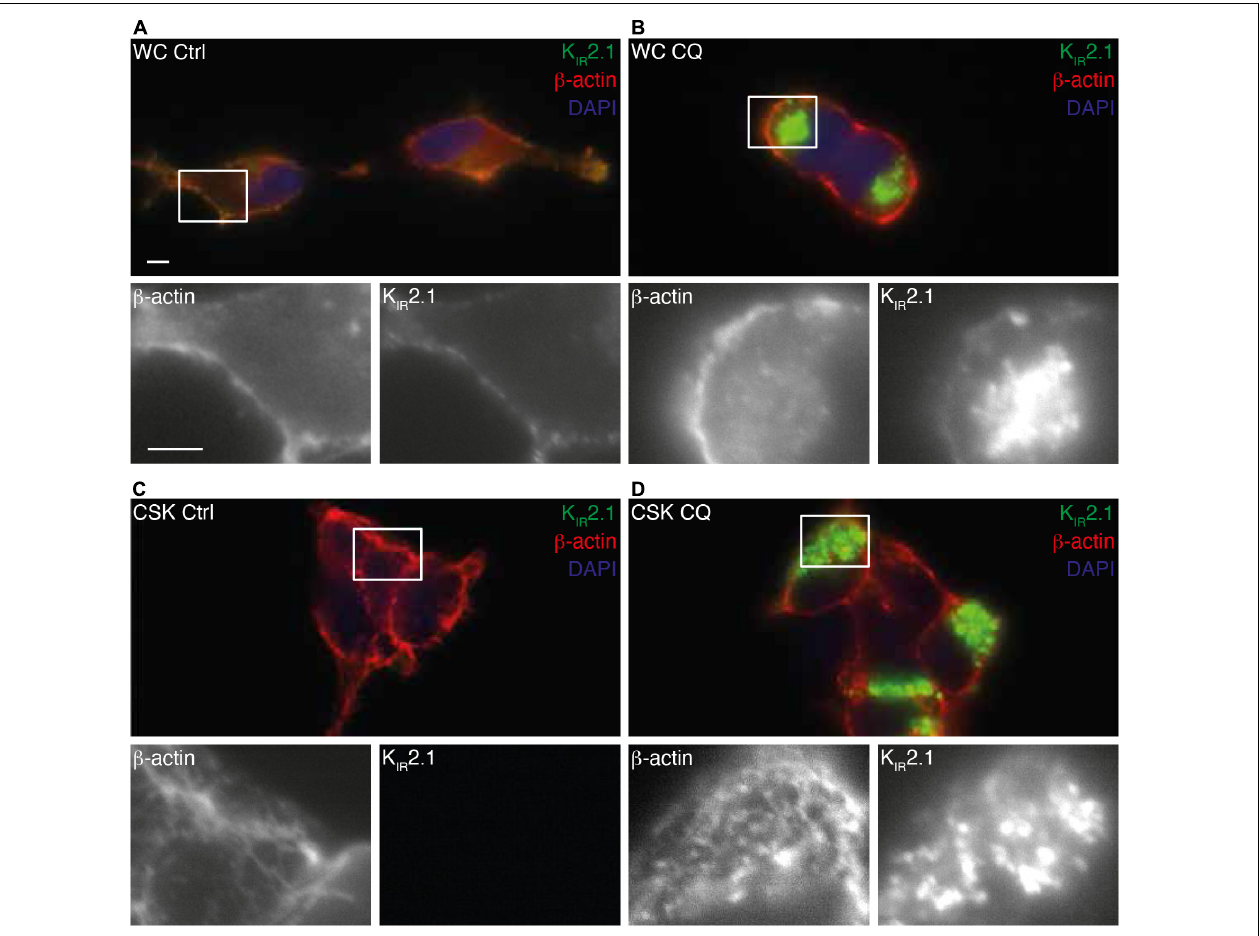
FIGURE 6 | Interaction of K IR 2.1-GFP with the cell cytoskeleton following Chloroquine treatment. Co-staining of K IR 2.1-GFP (green) and β -actin in non-treated whole cell (WC) (A,B) or cytoskeleton isolated (CSK) (C,D) HEK-KWGF cells. Cells were either non-treated (Ctrl) (A,C) or treated with 10 µ M CQ for 24 h (B,D) . Single staining patterns of the boxed areas are shown below each picture. Scale bar represents 5 µ